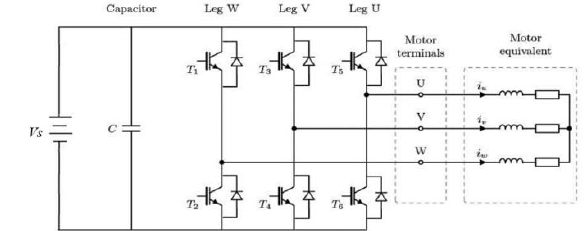
Figure 3. Simplified inverter topology.